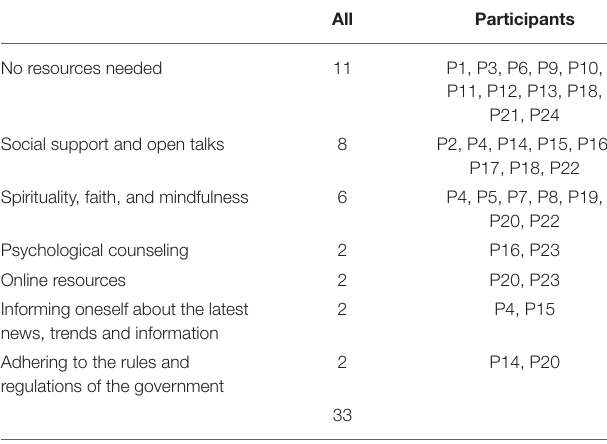
TABLE 2 | Feelings when experiencing COVID-19.